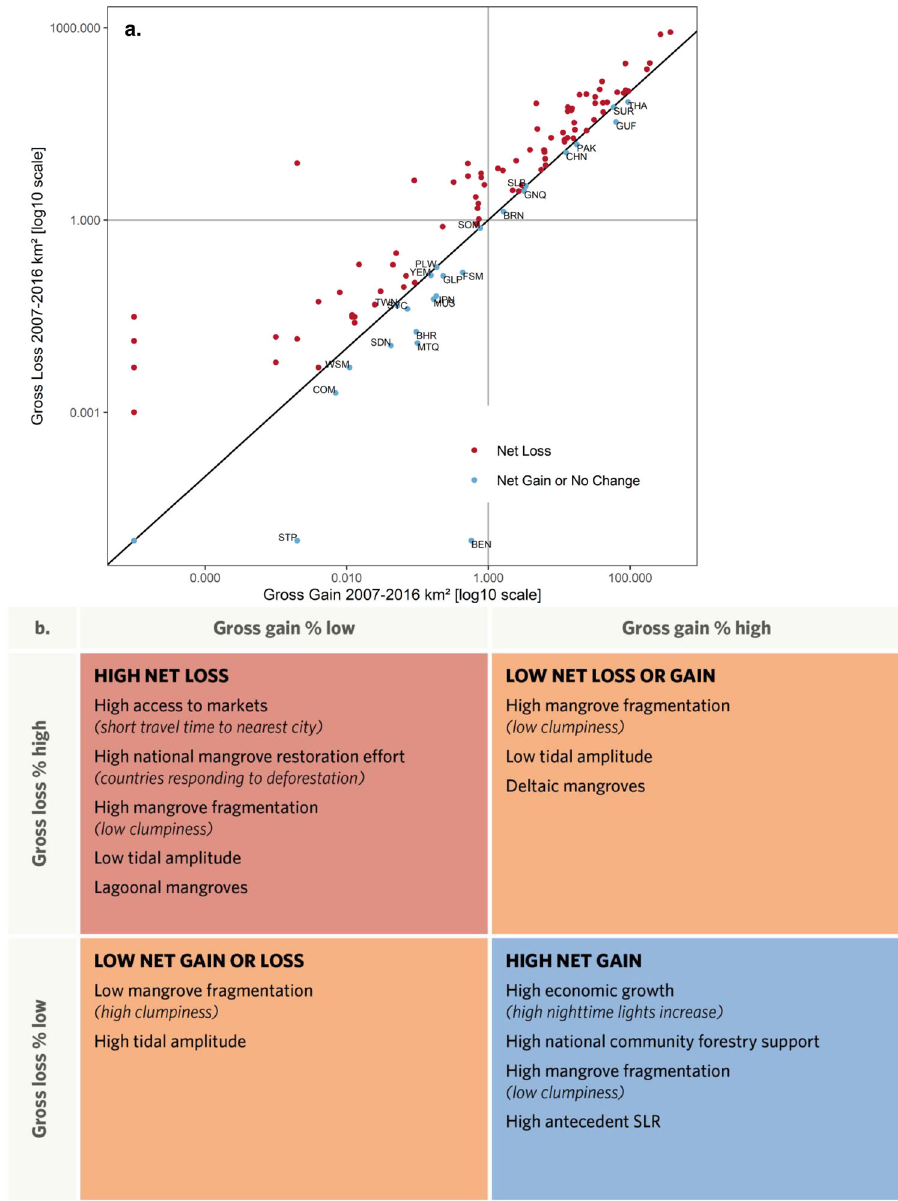
Fig. 2 | Nexus of mangrove losses and gains. a National gross losses and gains in mangrove coverdetected within109mangrove countriesbetween 2007 and 2016. Pointsarecolouredbythecountry ’ snetchangethatfallaboveorbelowthe1:1line, respectively. The horizontal and vertical lines visualise where countries fall on the gradientofgrosslossandgain,respectively.Countrieswithnetgainarelabelledby country code. BEN Benin, BHR Bahrain, BRN Brunei, CHN China, COM Comoros, FSMFederatedStatesofMicronesia,GLPGuadeloupe,GNQEquatorialGuinea,GUF